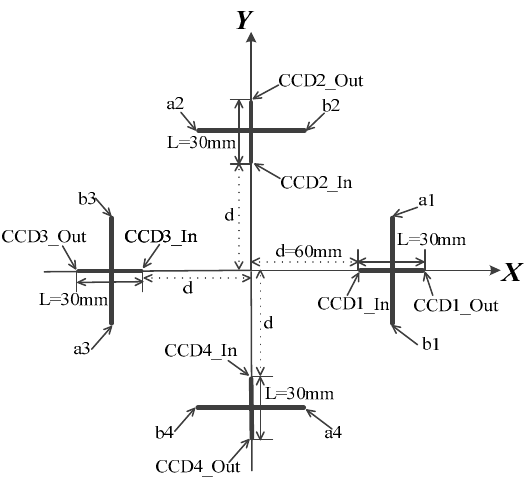
Figure 3. Layout design of the POS.